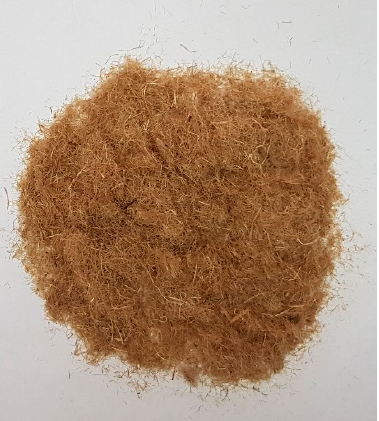
Figure 1. Jute particles used.